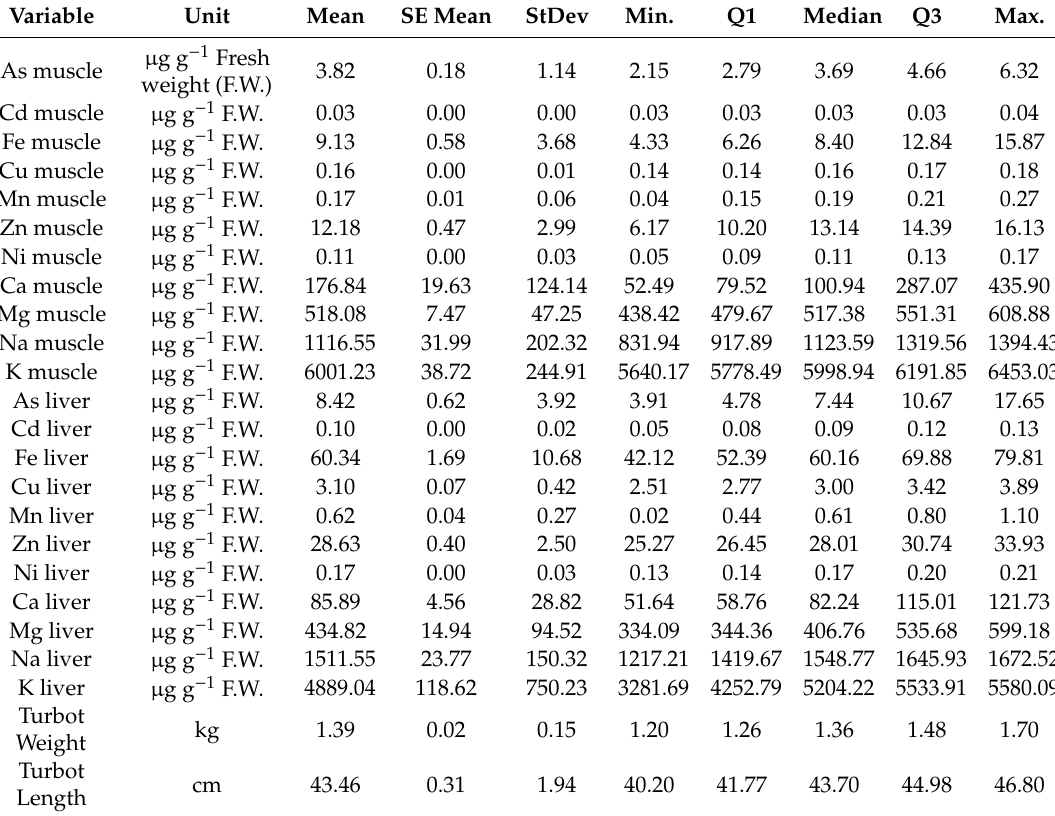
Table A3. Descriptive statistics of first group dataset.